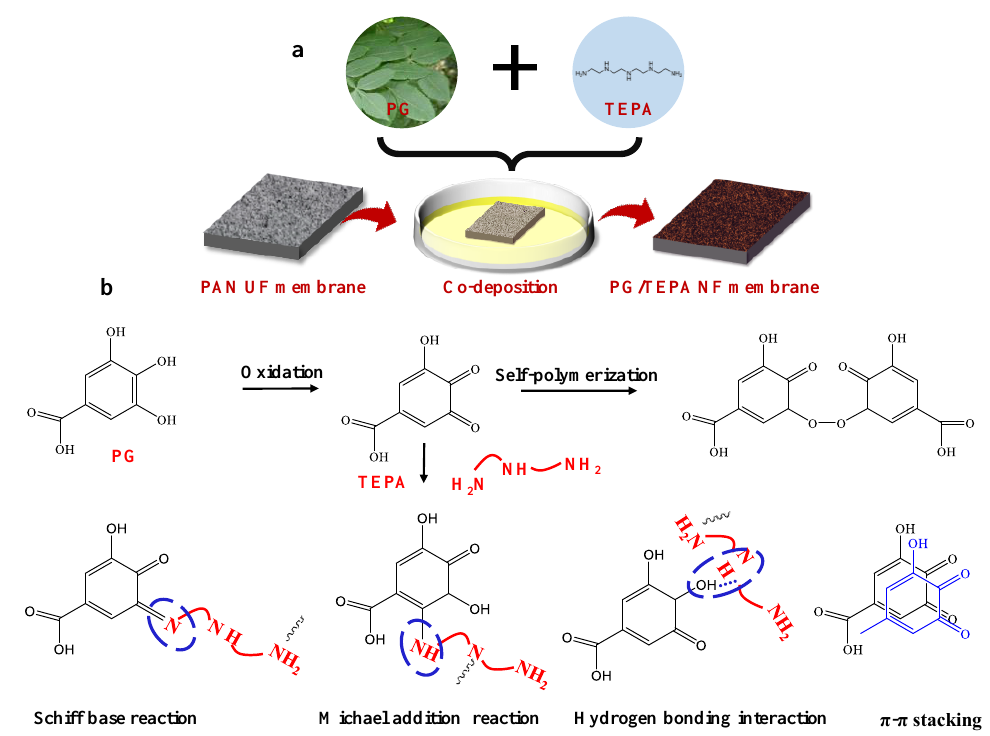
Figure 1. ( a ) Preparation process of PG/TEPA NF membrane and ( b ) possible reaction mechanism between PG and TEPA.